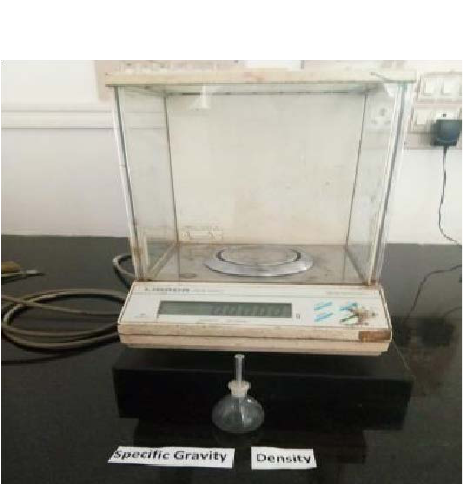
Figure 2: Experimental setup for Flash and Fire Point test as per IS:1448 (Part 66)